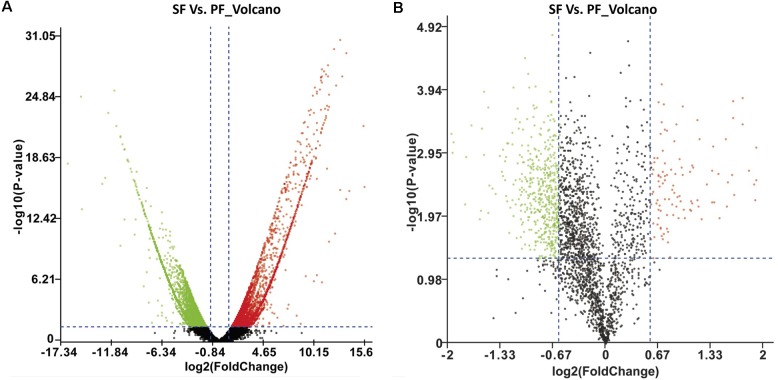
Volcano plot of DEGs and DEPs in SF and PF. (A) Volcano plot of DEGs in SF and PF. Splashes represent different genes, and the black splashes mean genes without significant different expression. The red splashes mean significantly up-regulated genes in SF, and the green splashes mean significantly down-regulated genes in SF. (B) Volcano plot of DEPs in SF and PF. Each point represents a specific protein, and the black points are the non-significant different proteins. The red dots indicate the significantly up-regulated proteins in SF, and the green dots indicate the significantly down-regulated proteins in SF. SF, sexual female; PF, parthenogenetic female, -log10 (p-value): the corrected p-value.